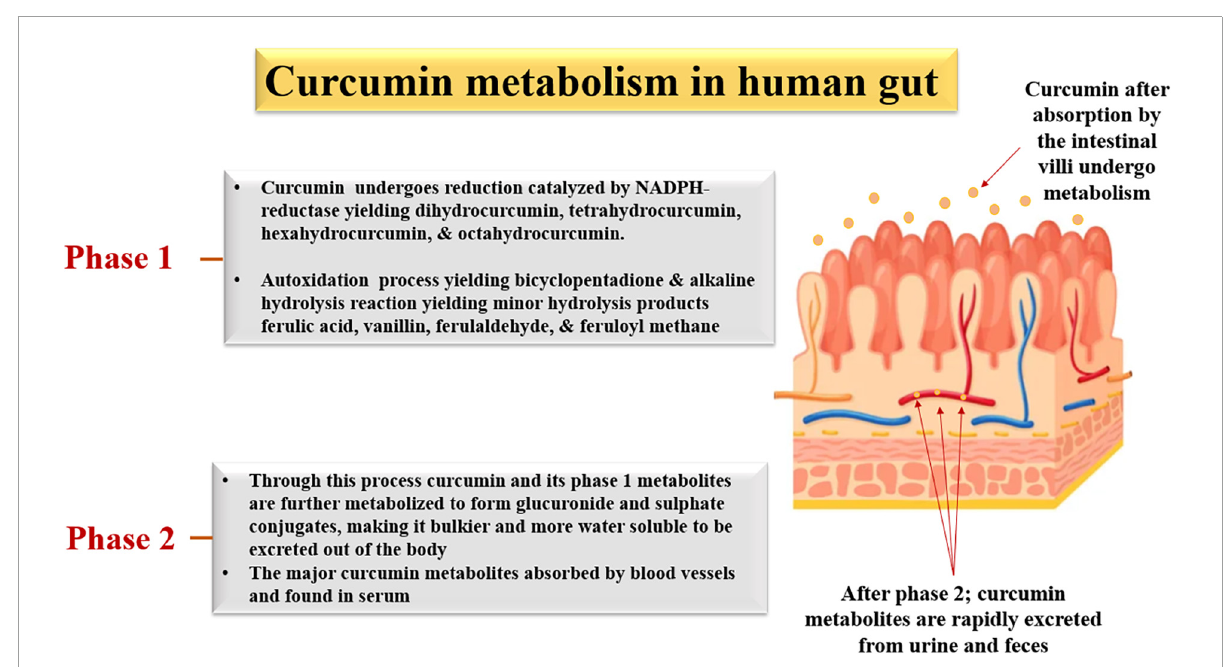
FIGURE3 Phase I and Phase II metabolism of curcumin in epithelium